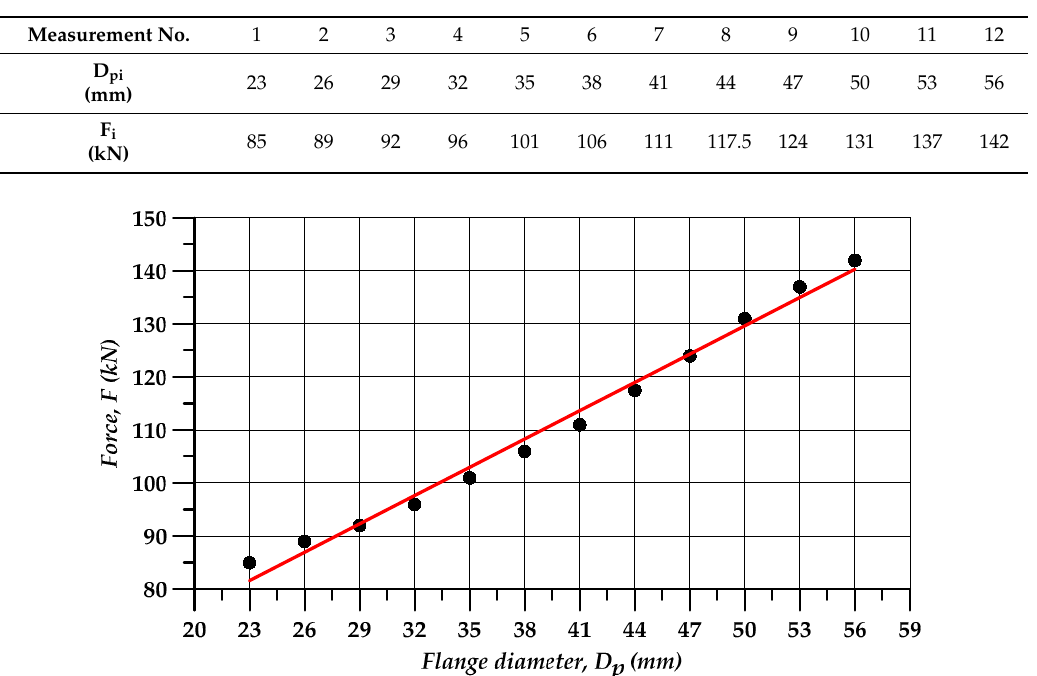
Table 3. Maximum extrusion force versus inside diameter of the ring (denotations according to Figure 1).